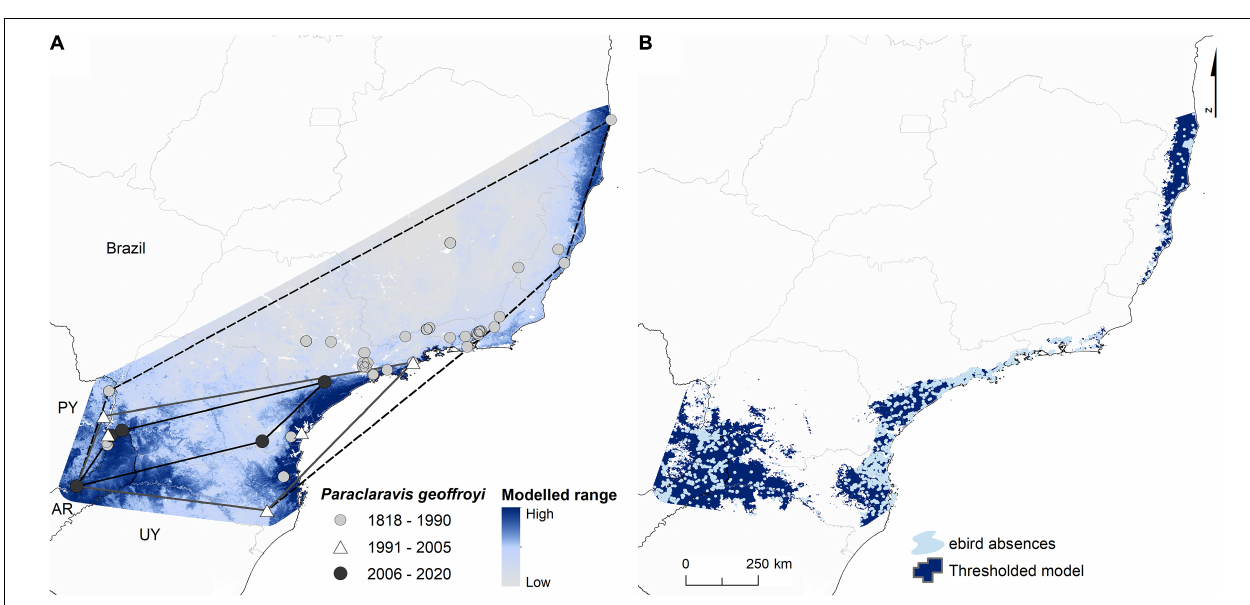
FIGURE 4 | (A) Extent of occurrence and modeled range of Purple-winged Ground Dove, showing all known records. The dashed black line corresponds to the EOO for all records, the gray line to records 1991–2005, and the solid black line to 2006–2020. (B) Thresholded model overlaid with eBird absences, showing priority areas to conduct searches (PY, Paraguay; AR, Argentina; UY,